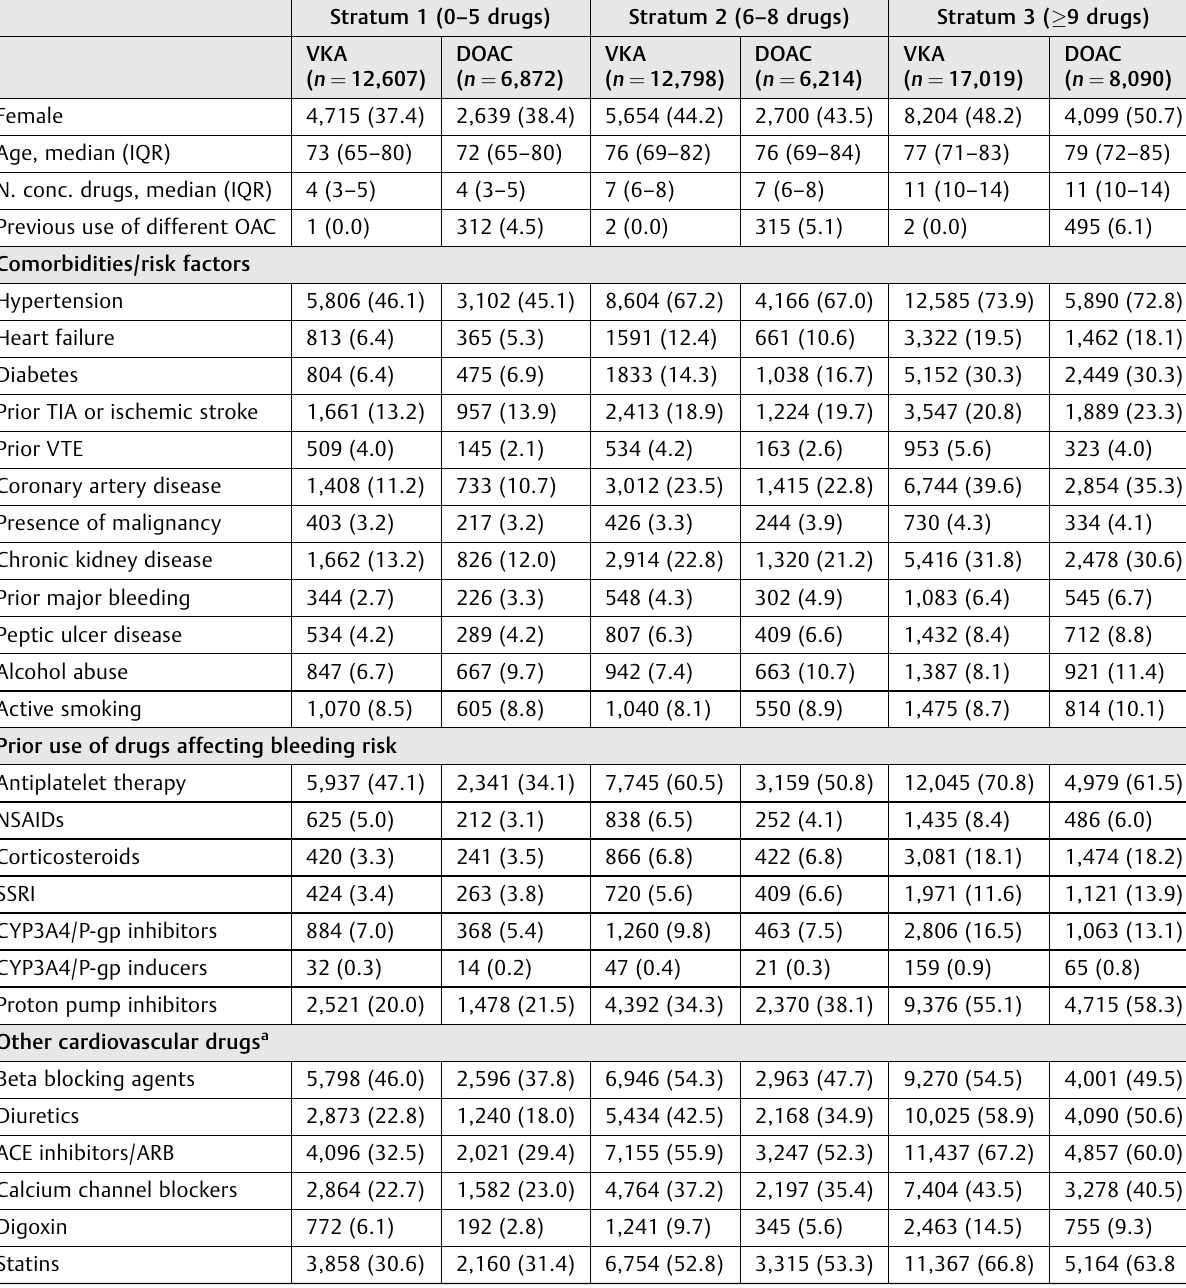
Table 1 Baseline characteristics per stratum of the number of concomitant drugs